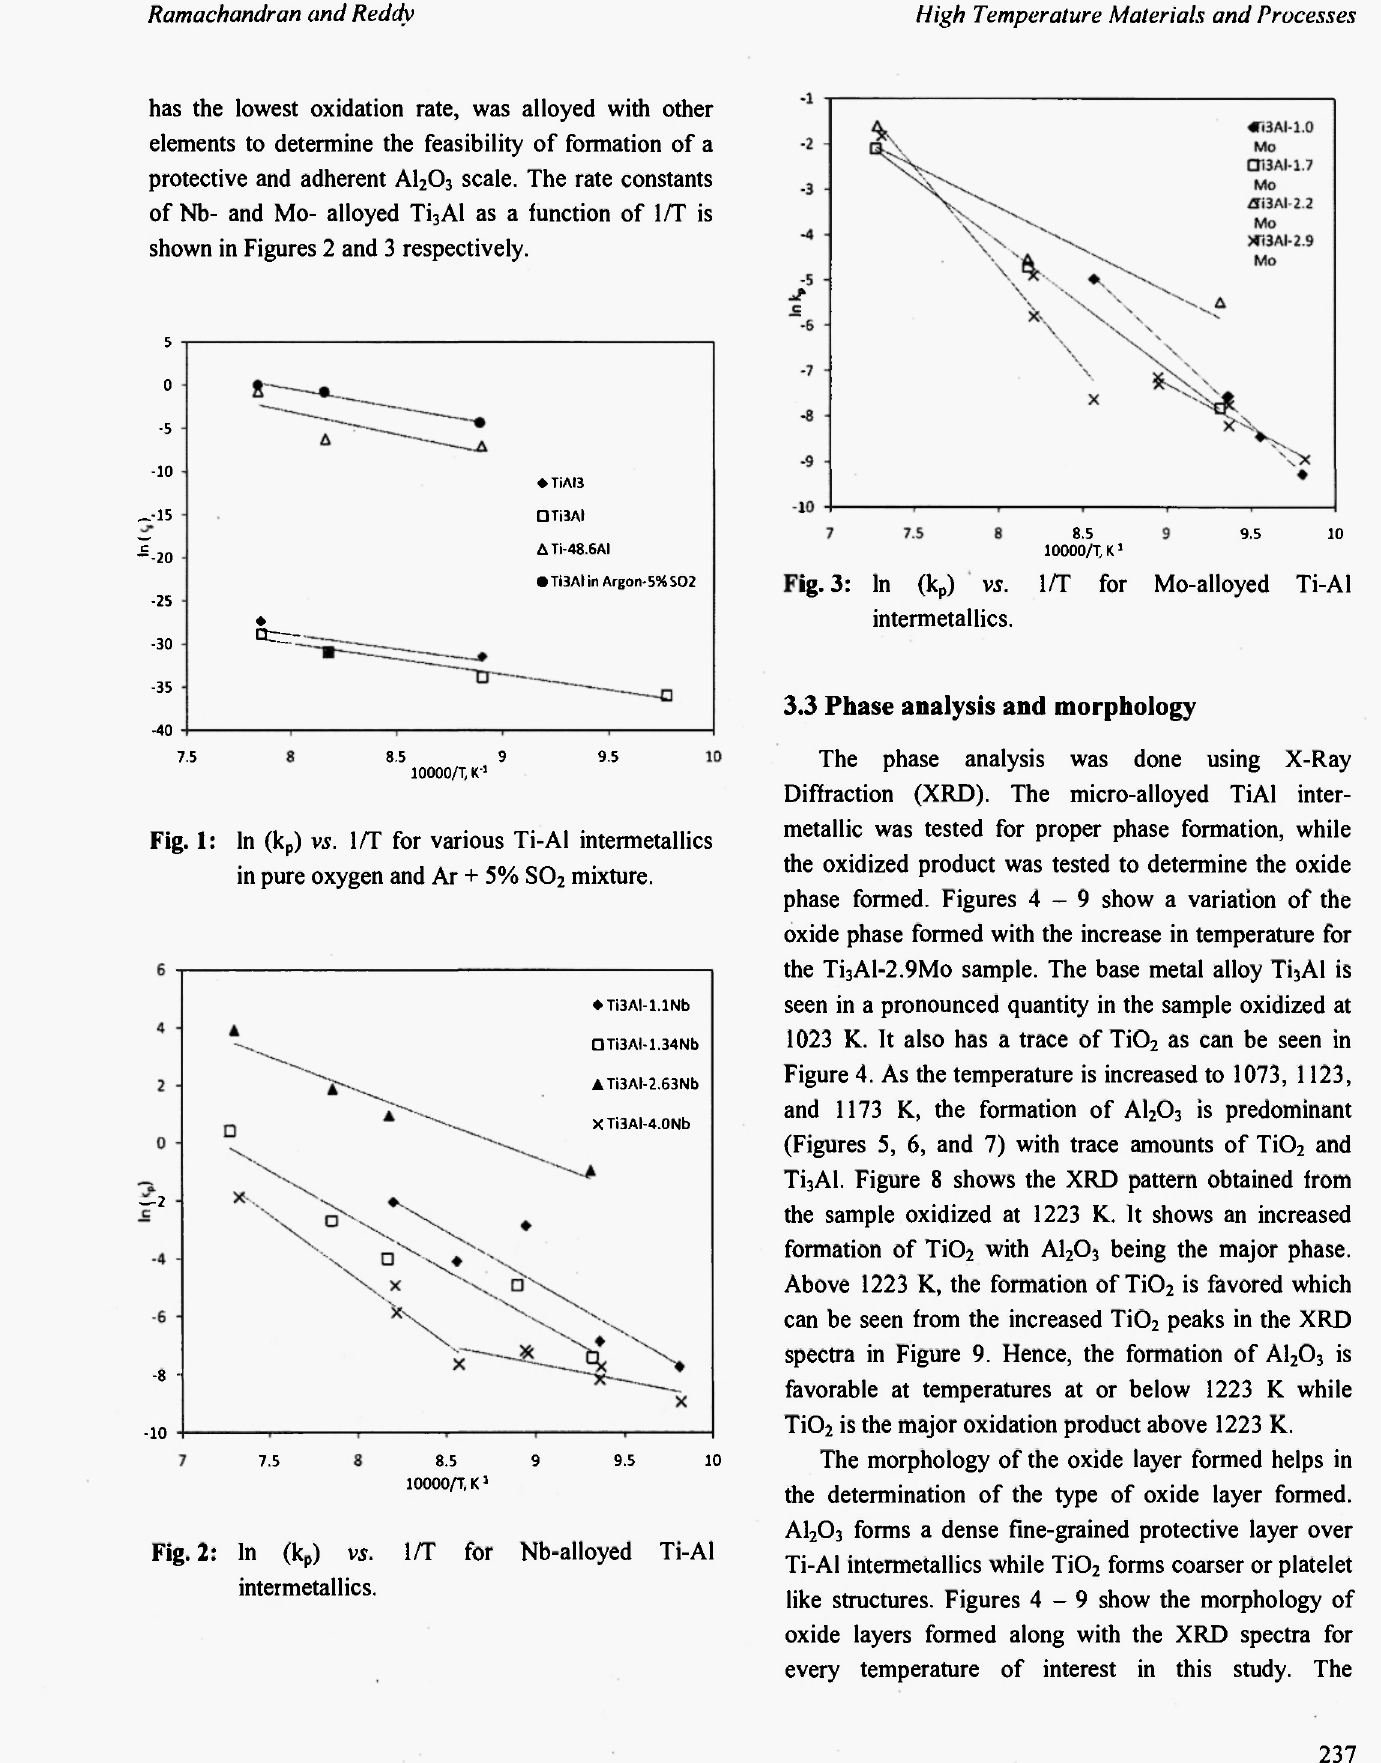
Fig. 2: In (k p ) vs. 1/T for Nb-alloyed Ti-Al